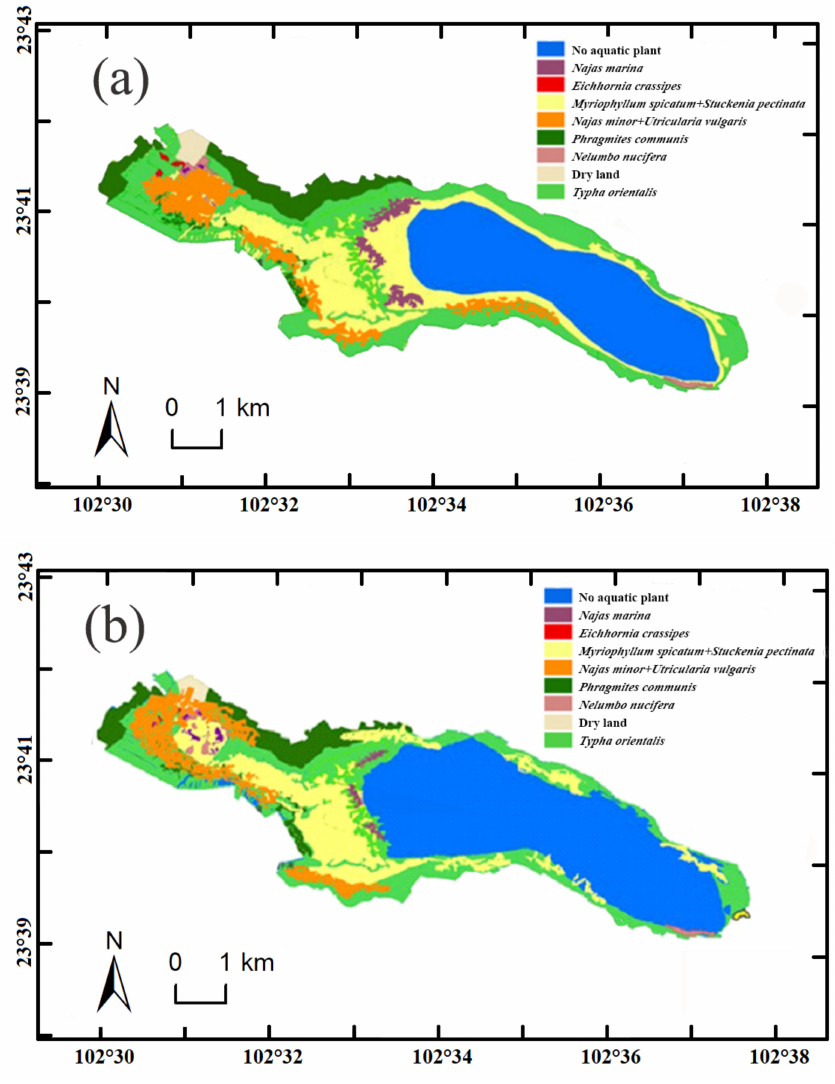
Figure 6. The distribution of aquatic plants during low water level and high water level periods in Yilong Lake. ( a ) The distribution of aquatic plants during low water level periods (March 2014); ( b ) the distribution of aquatic plants during high water level periods (March